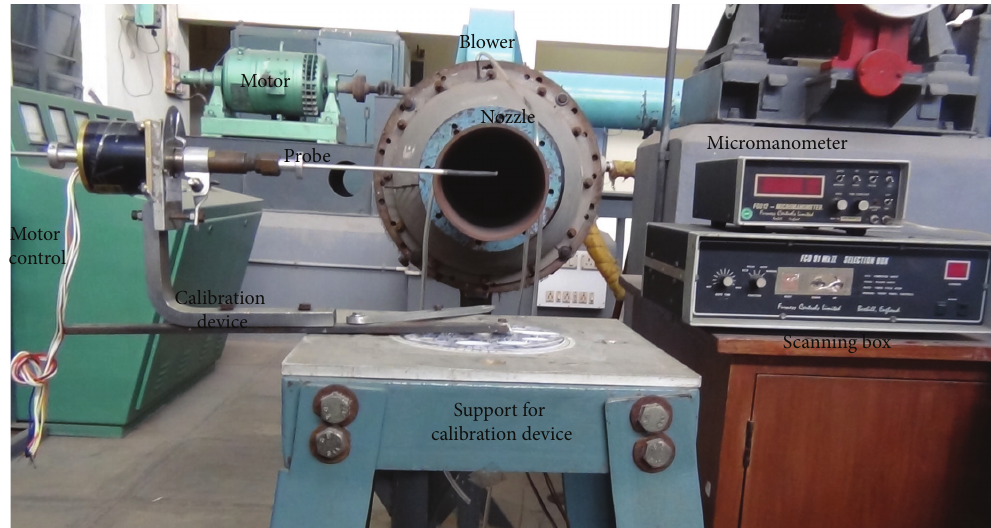
Figure 3: Calibration tunnel, calibration device, probe, and instrumentation.